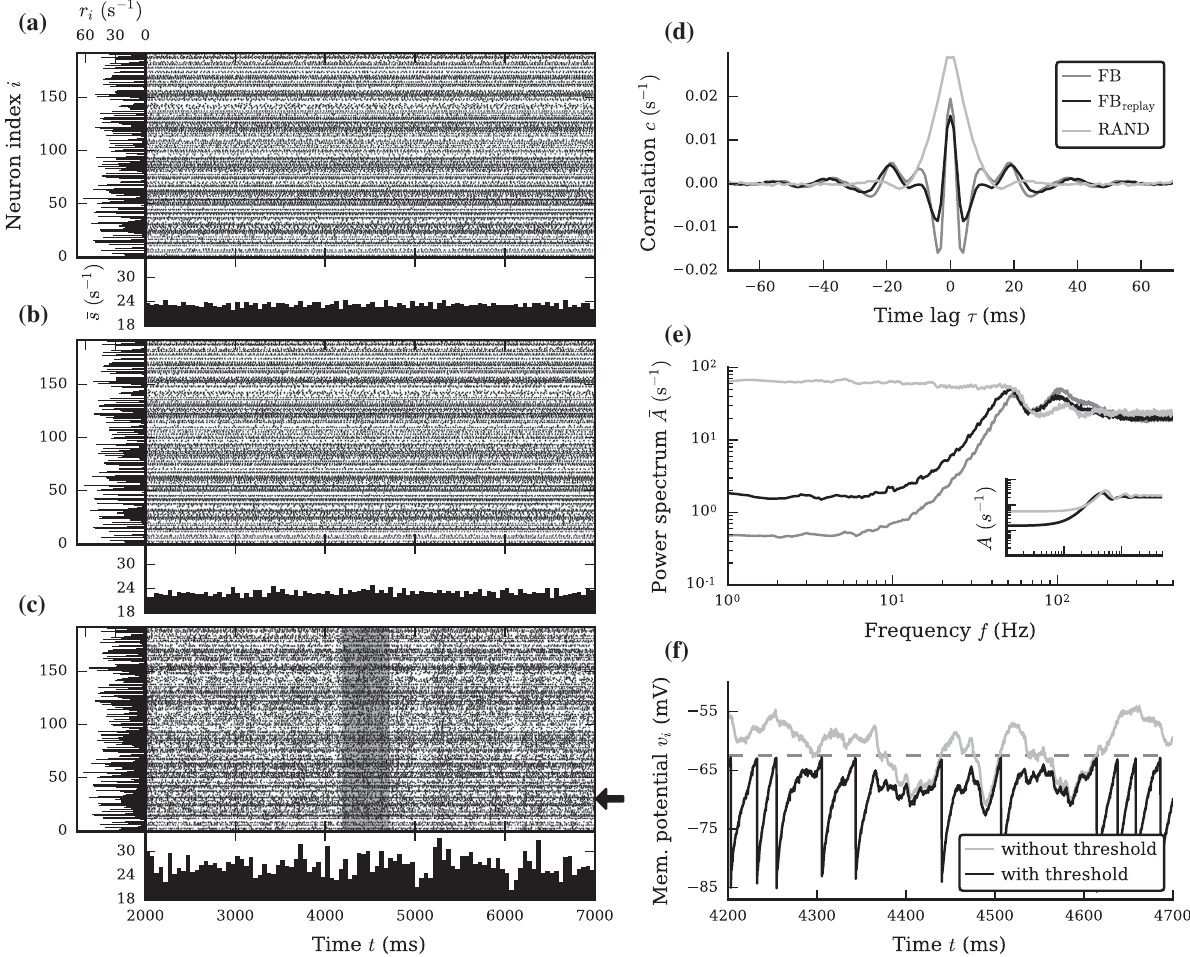
FIG. 5. Typical spiking and membrane-potential activity of a random inhibitory network of LIF neurons with intact and cut feedback loop emulated on the fully calibrated system. (a) – (c) Spiking activity (raster plots), population activity ¯ s ð t Þ (horizontal histograms, bin size 50 ms), and time-averaged single-neuron firing rates r (vertical histograms) in the network with intact feedback (a) and for cases i where the feedback loop is cut (b),(c). (a) Intact recurrent network (FB scenario). (b) Population of mutually unconnected neurons receiving input spike trains identical to those in (a) (FB scenario). (c) As in (b), but after randomization of presynaptic spike times replay (RAND scenario). (d),(e) Population-averaged cross-correlation functions c ð τ Þ (after offset subtraction) of pairs of spike trains (d) and ¯ A ð f Þ [(e) log-log representation] of the population activity ¯ s ð t Þ [cf. horizontal histograms in (a) – (c)] for the FB (dark gray power spectra line), FB (black line), and RAND scenario (light gray line). Inset in (e): Population-averaged power spectra A ð f Þ of individual replay single-cell spike trains (same scales as in main panel). Correlation functions and spectra are averaged across M ¼ 100 network realizations. (f) Membrane potential of a neuron in the RAND scenario [with firing rate of 23 . 20 s − 1 close to population average of 23 . 24 s − 1 ; see black arrow in (c)] with intact (black curve) and removed threshold (gray curve; free membrane potential). The threshold potential is marked by the horizontal dashed line. The time frame corresponds to the gray shaded region in